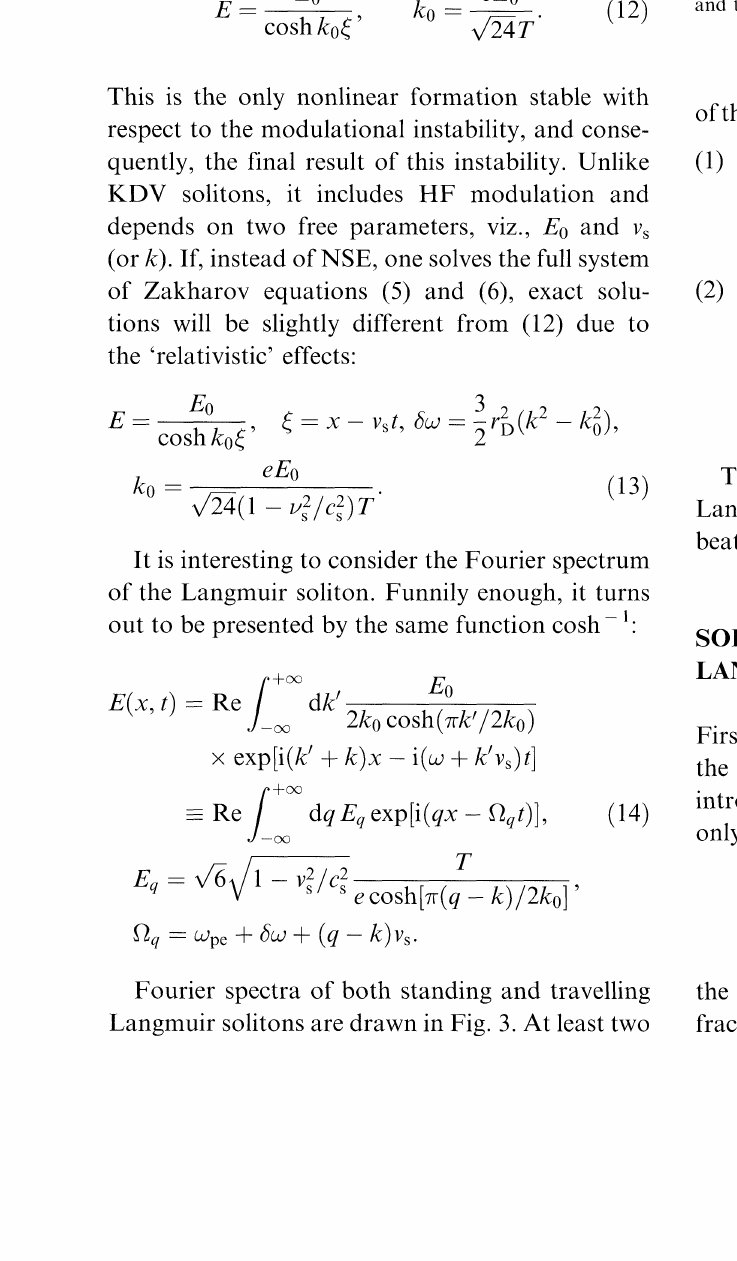
FIGURE 3 Fourier spectra of both immovable (solid line) and travelling (dotted line) Langmuir